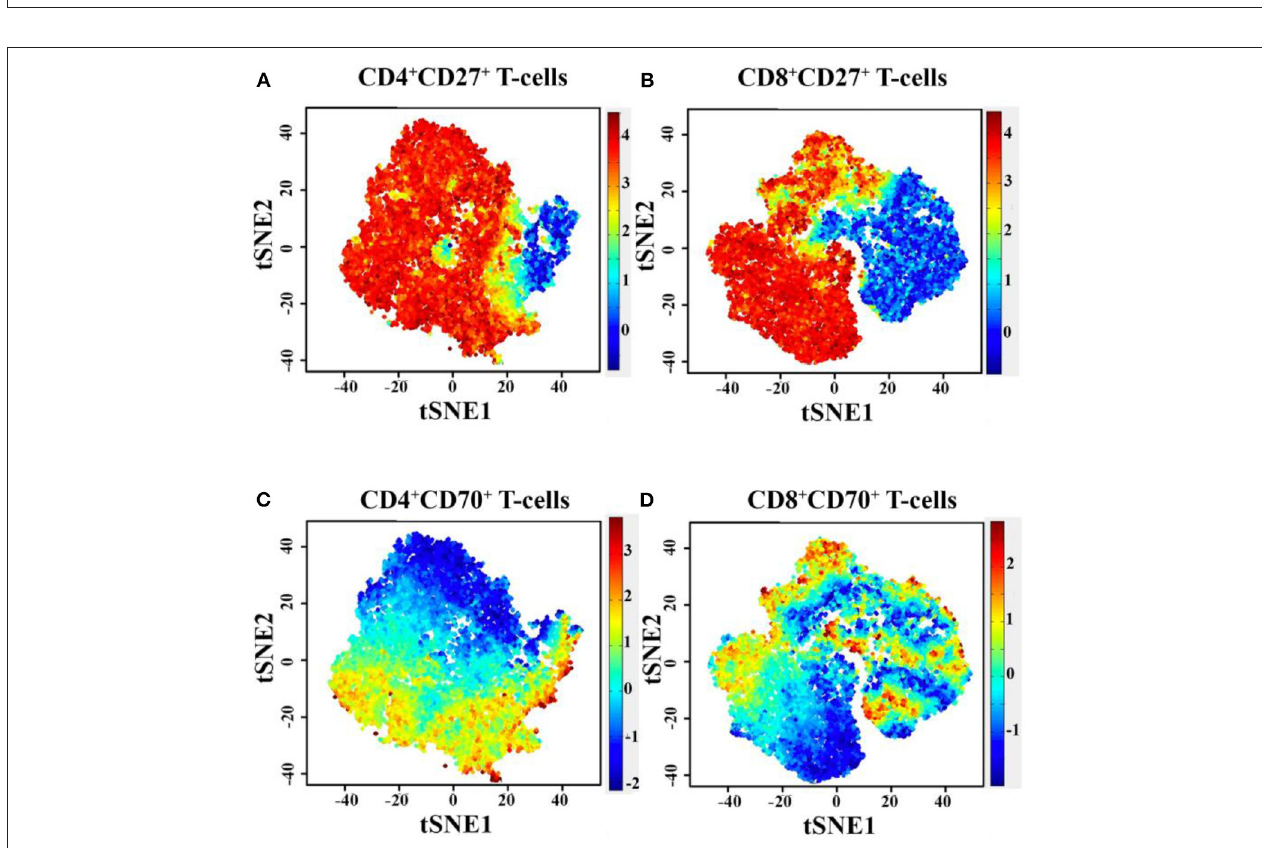
FIGURE 2 | memory- (EM-), and effector (Eff-) like T-cell populations. Localization of each PhenoGraph-derived subcluster and overlapped plotted viSNE map of individuals within the viSNE map for CD4 + and CD8 + T cells was shown in (E,F) and (G,H) , respectively (for more information about each PhenoGraph population, see Supplementary Tables 4, 5 ). In (I,J) , each subject’s phenotypic data were plotted on the viSNE map, represented with different colors (blue, proband; green, homozygous brother; red, heterozygous father; black, healthy control). Naive-, CM/TM-, EM-, and Eff-like T-cell populations were marked within the viSNE plot based on the subclusters that were determined using PhenoGraph in sections (E–H) .